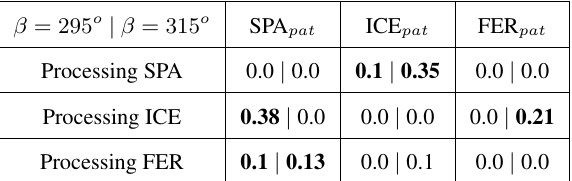
Table 5. Similarity values 0 < S < 1 retrieved for X band simulations in scenario 0 with the p single-pol mode. Bold numbers indicate the model classifying the processed geometry, so if arranged along the matrix diagonal, VCA performs